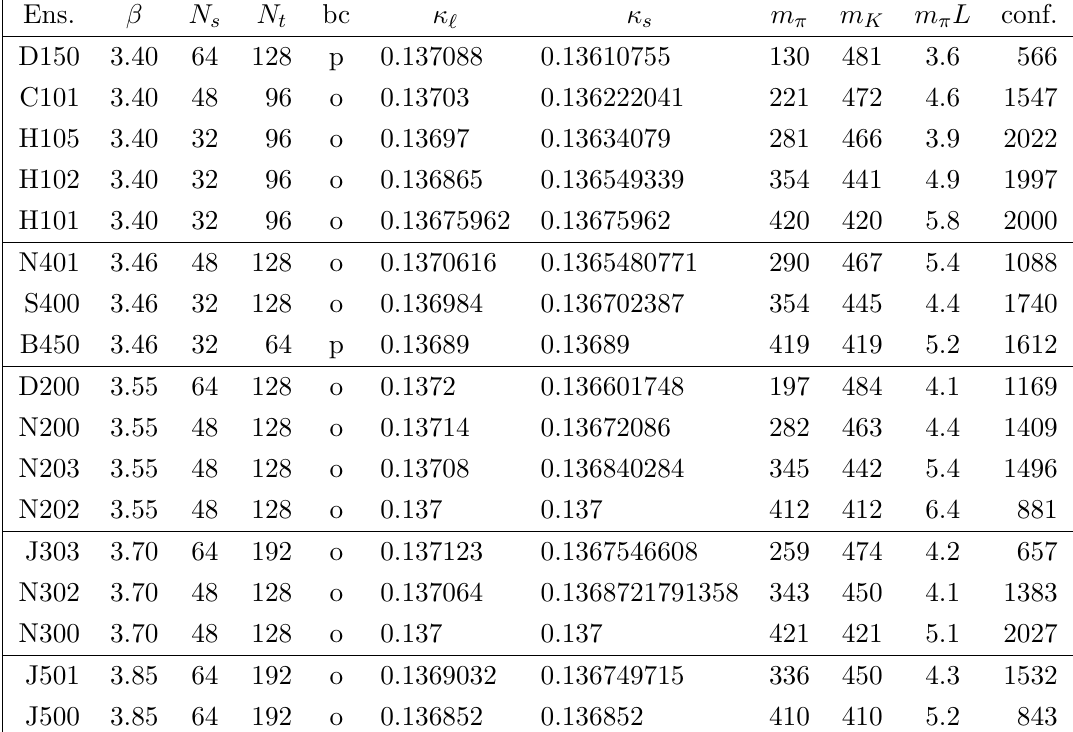
Table 6 . List of the ensembles on the Tr M = phys. trajectory. The inverse gauge coupling (cid:12) determines the lattice spacing (cf. table 1), while the spatial and temporal extents (cid:12)x the lattice geometry N 3 (cid:2) N t . Boundary conditions in time direction are either periodic (p) or open (o). The s light and strange hopping parameters, (cid:20) ‘ and (cid:20) s , determine the corresponding quark masses; the resulting approximate meson masses m (cid:25) and m K are given in units of MeV, followed by the spatial lattice size in pion mass units. Finally, we give the number of gauge con(cid:12)gurations used to measure the second moments.